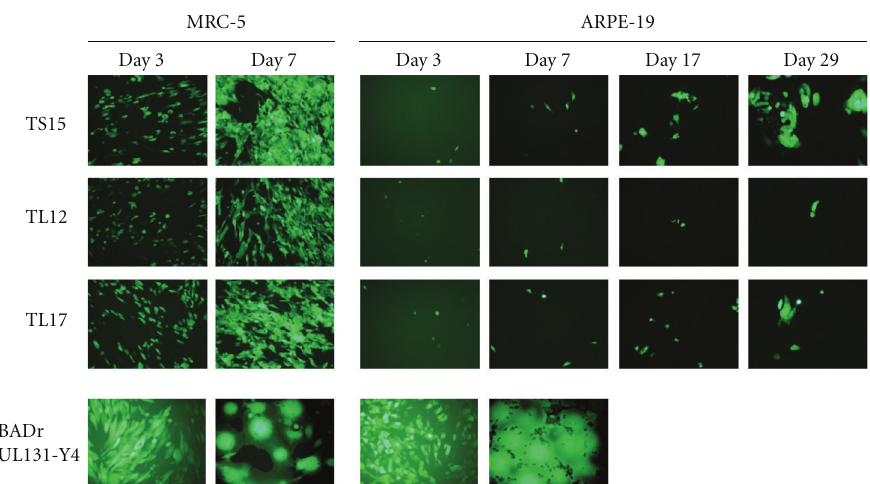
Figure 4: Entry and spread of BAC-derived viruses in MRC-5 or ARPE-19 cells. Confluent cell monolayers were infected with matched inocula (10 4 pfu) of the indicated GFP+ viruses. Representative micrographs (8X final magnification) were taken on the days indicated.